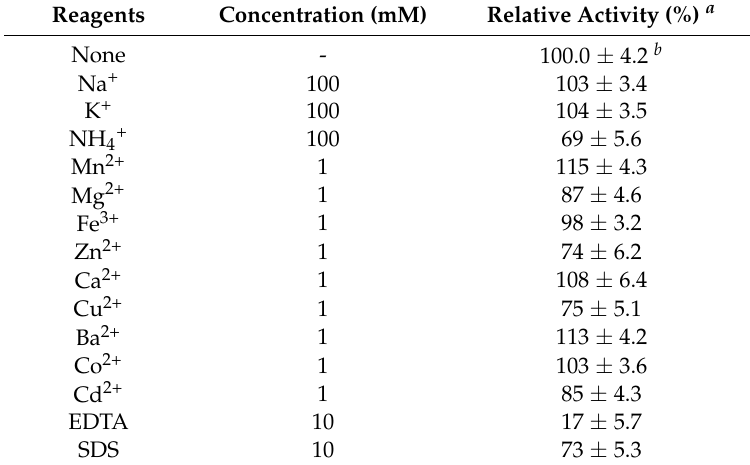
Table 1. Effects of various metal ions and chemical reagents on the activity of